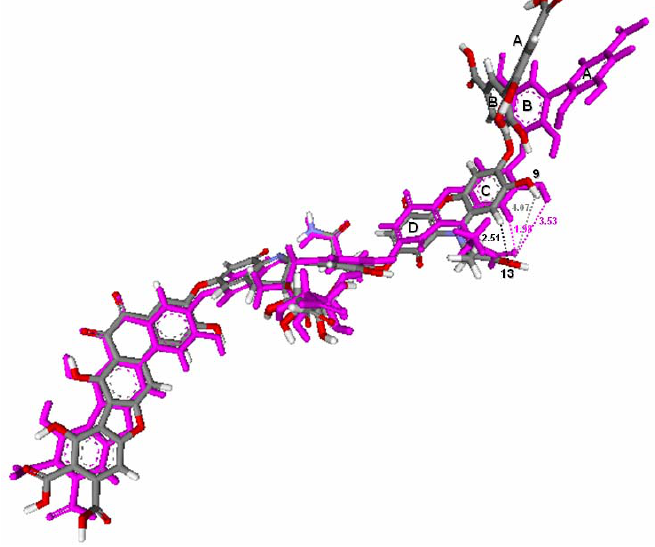
Figure 5 . Fitted structures of HA (atom-type color) and ionized HA (magenta).